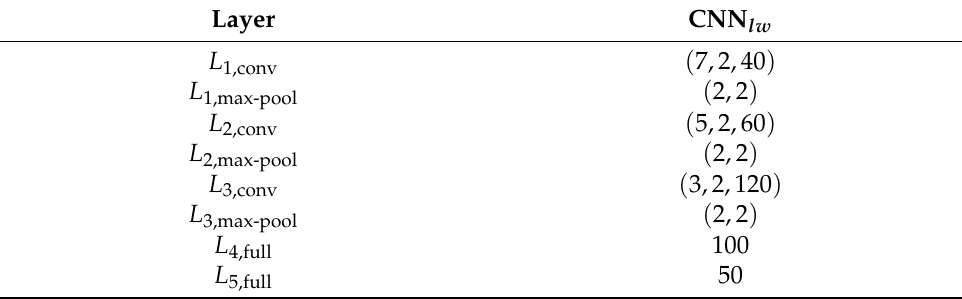
Table 2. Configuration of the lightweight